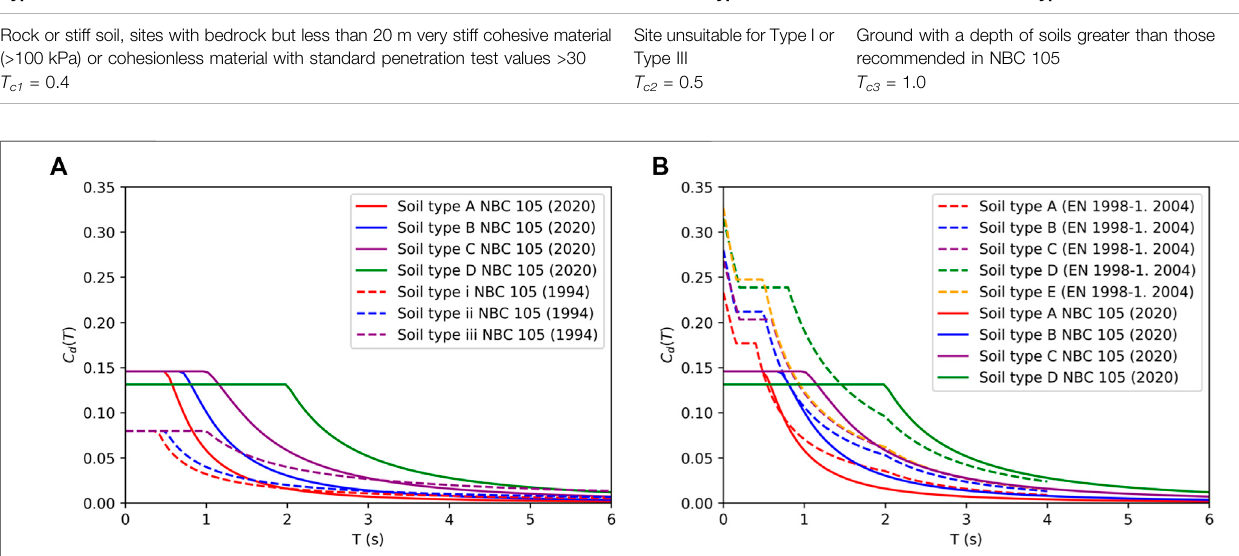
TABLE 1 | Soil classi fi cation for NBC 105; T ci is the corner period for each ground type. Type I